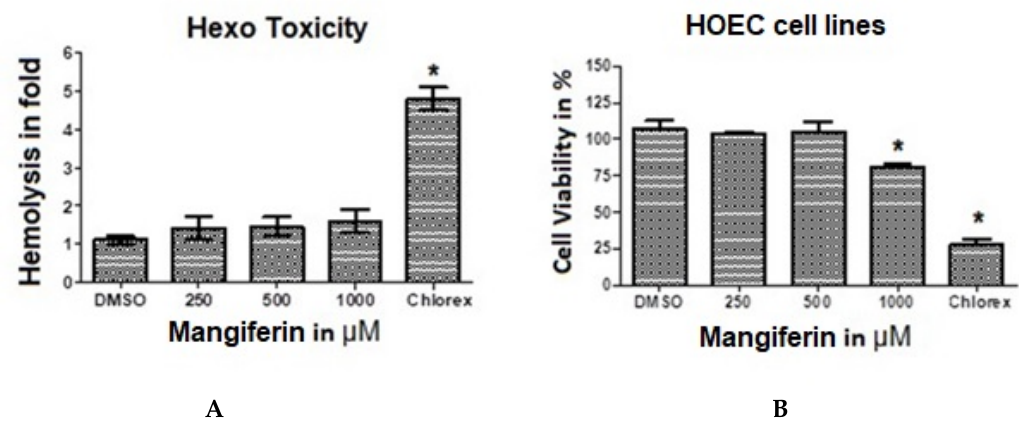
Figure 8. Hemolysis and Cytotoxicity of mangiferin. Hemolytic activity of mangiferin in concentrations of 250 and 500 µm against human RBC cells and HOEC cells. After 24 h of incubation with the mangiferin, ( A ) Hemolytic activity of the mangiferin against red blood cells. The release of hemoglobin was measured using a microplate reader at 414 nm. Hemolytic level was noted in fold. ( B ) Cytotoxicity was measured using an MTT (3-(4, 5-dimethylthiazol-2-Yl)-2, 5-diphenyltetrazolium bromide) assay. * p <0.05 represents significant difference between the control and. mangiferin treated